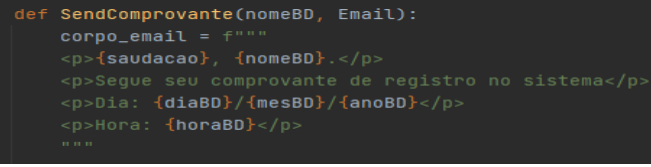
Figure 16: Function to send voucher via email.